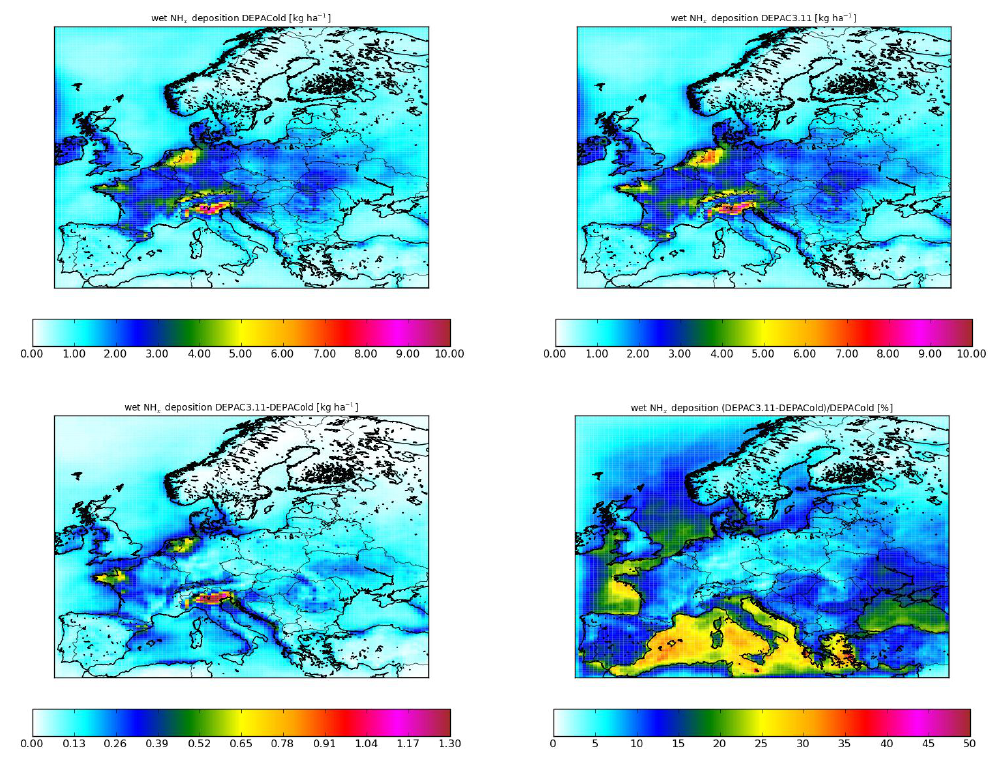
Figure 5. The yearly mean wet NH deposition as calculated by the LOTOS-EUROS model with the x Fig. 5. The yearly mean wet NH x deposition as calculated by the LOTOS-EUROS model with the DEPACold (upper left) and DEPAC3.11 'DEPACold' (upper left) and 'DEPAC3.11' module (upper right) for the year 2007. The lower left module (upper right) for the year 2007. The lower left figure shows the absolute difference, and the lower right figure shows the relative figure shows the absolute difference and the lower right figure shows the relative difference between difference between the two model calculations. The grid resolution in these figures is 0.50 ◦ longitude × 0.25 ◦ latitude ( ∼ 28 × 28km 2 ) . the two model calculations. The grid resolution in these figures is 0.50° longitude x 0.25° latitude (~28x28 km 2 ).